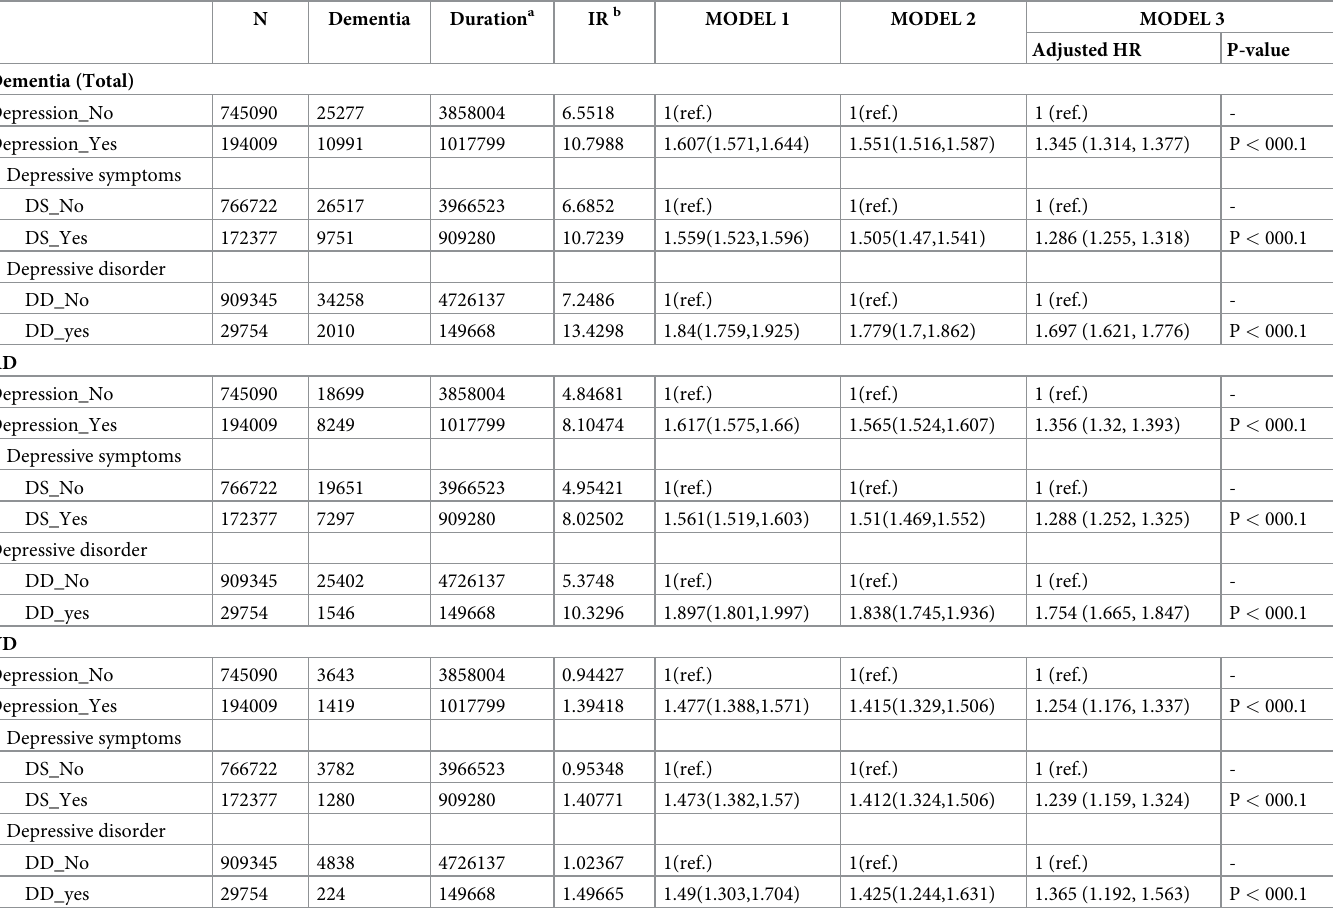
Table 2. Risk of total dementia, AD, and VD according to presence of depressive symptom or depressive